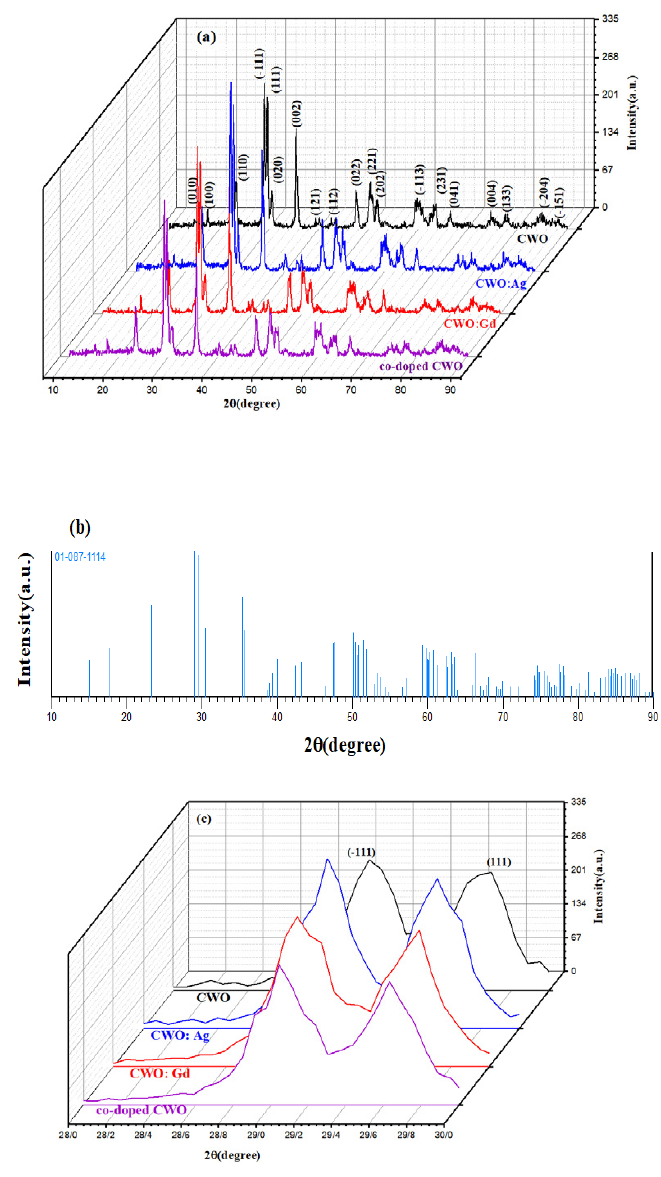
Figure 1 (a). Diffractograms of CWO, CWO: Ag/Gd, and co-doped CWO nanopowders, (b). 01-087-1114 data of CWO. (c). Comparison between the most intense diffraction peaks corresponds with (-111) and (111) planes.